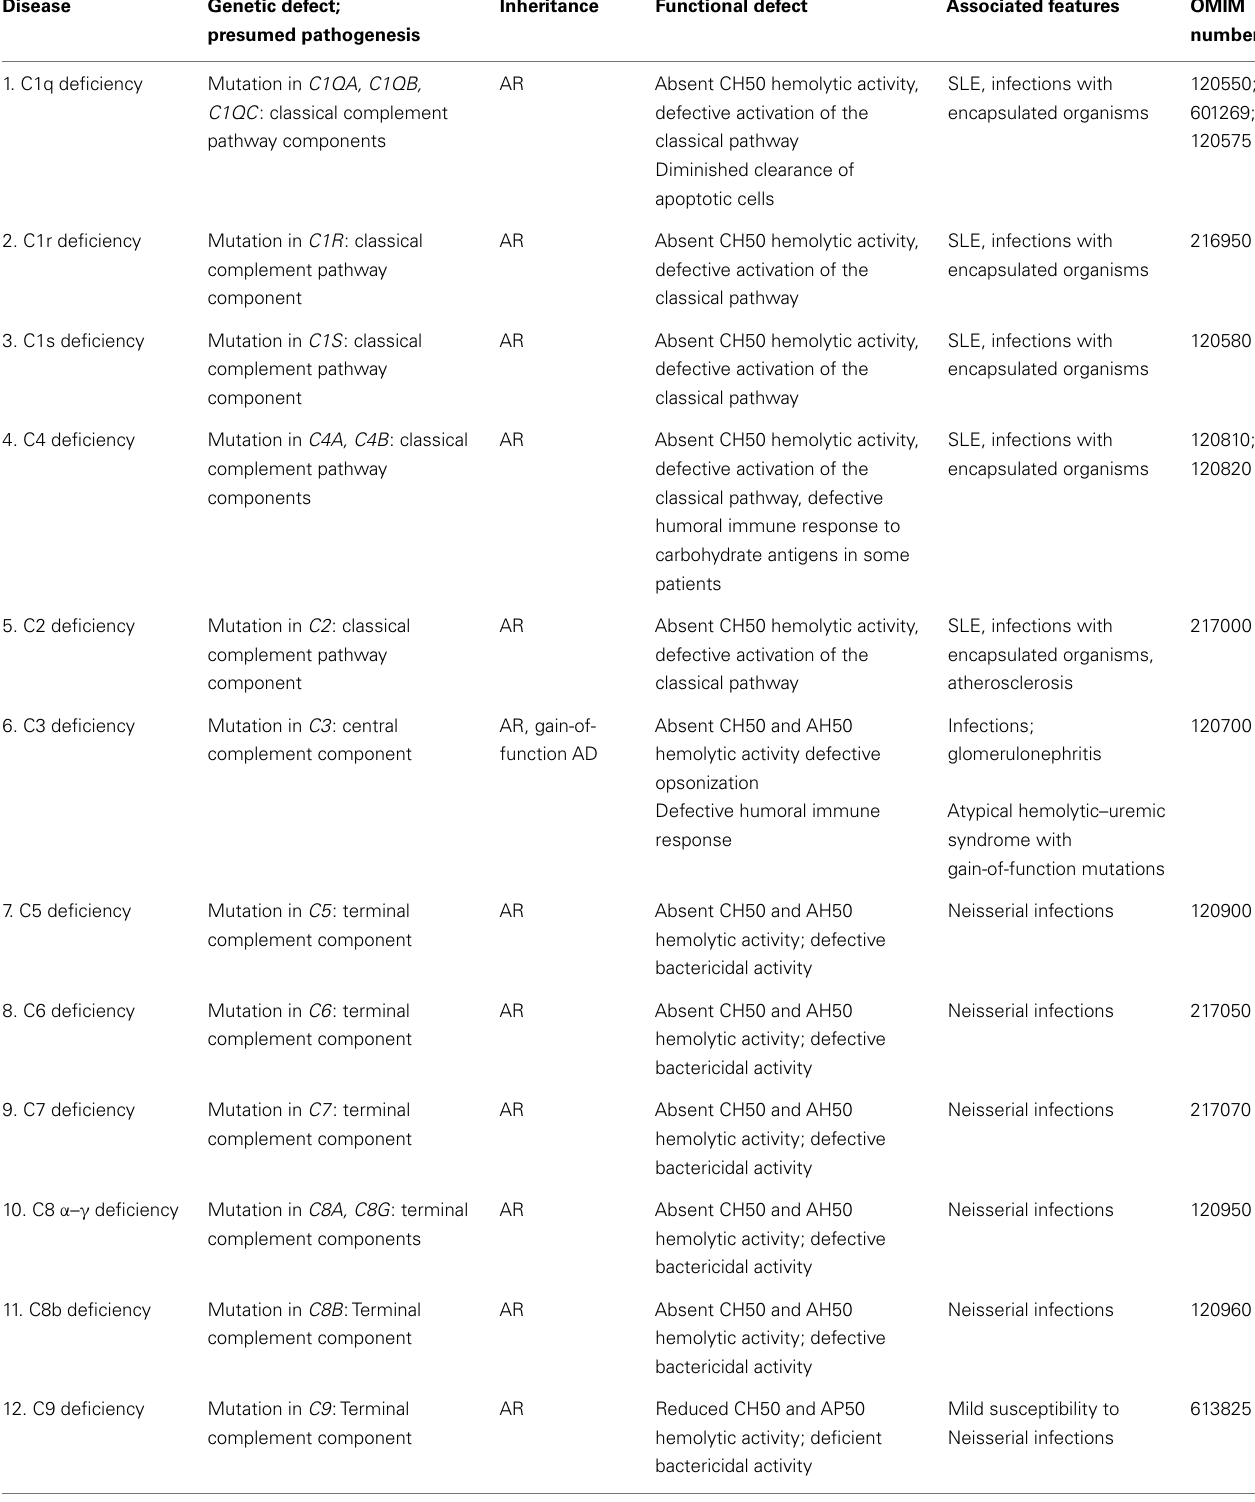
Table 8 | Complement